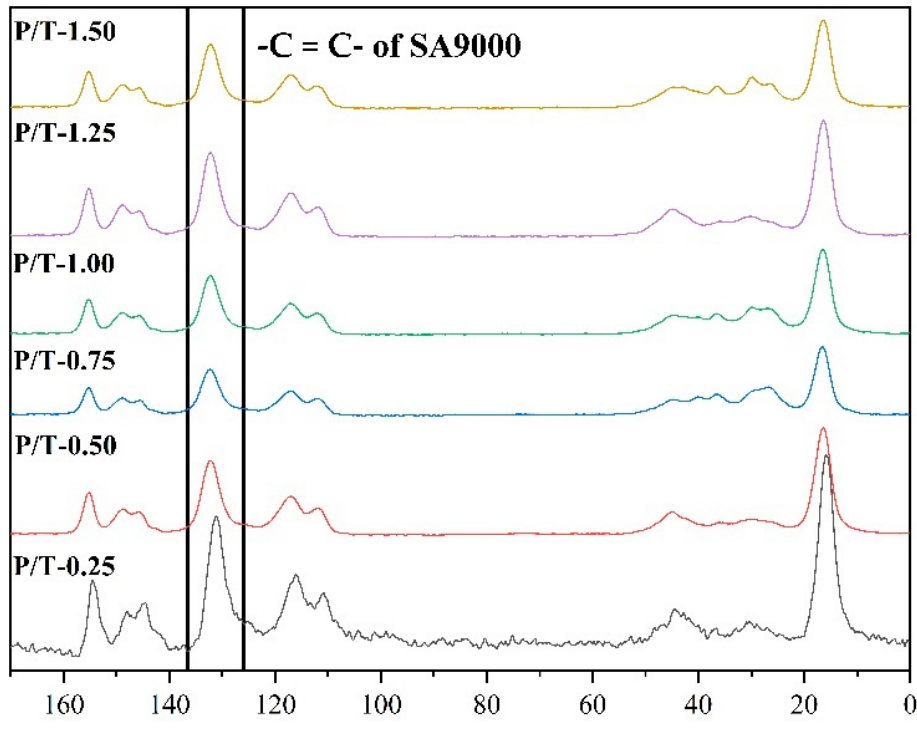
Figure 2. The SSNMR spectra of cured samples.